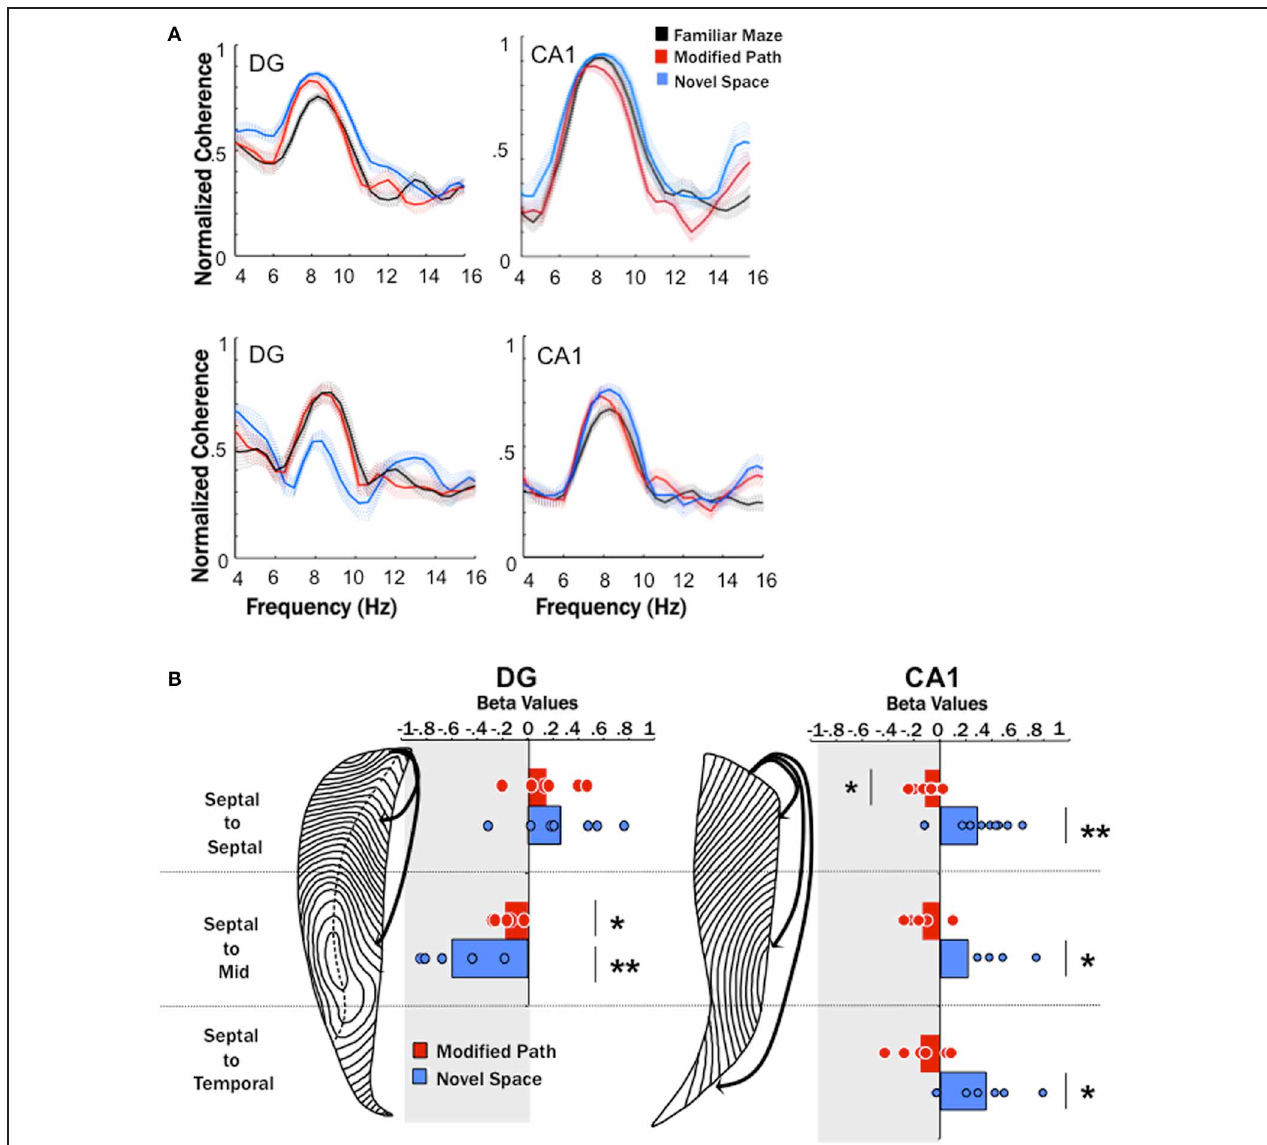
FIGURE 4 | Theta coherence decreases across the long axis of the dentate (DG) and increases across the long axis of CA1. (A) Averaged coherence for a pair of electrodes within one animal across all data segments (trials) during the familiar maze condition (black), on the modified path (red), and in a novel space (blue) in the DG and CA1. The hatched areas indicate the standard error of the mean across trials. The top row illustrates an increase in coherence between two septal dentate sites (left) and two septal CA1 electrode sites during navigation in novel (blue) space. The bottom row illustrates a decrease in coherence between a septal and a mid-septotemporal dentate electrodes sites (left) and an increase in coherence between a septal and mid-septotemporal CA1 electrode sites (right) during navigation in